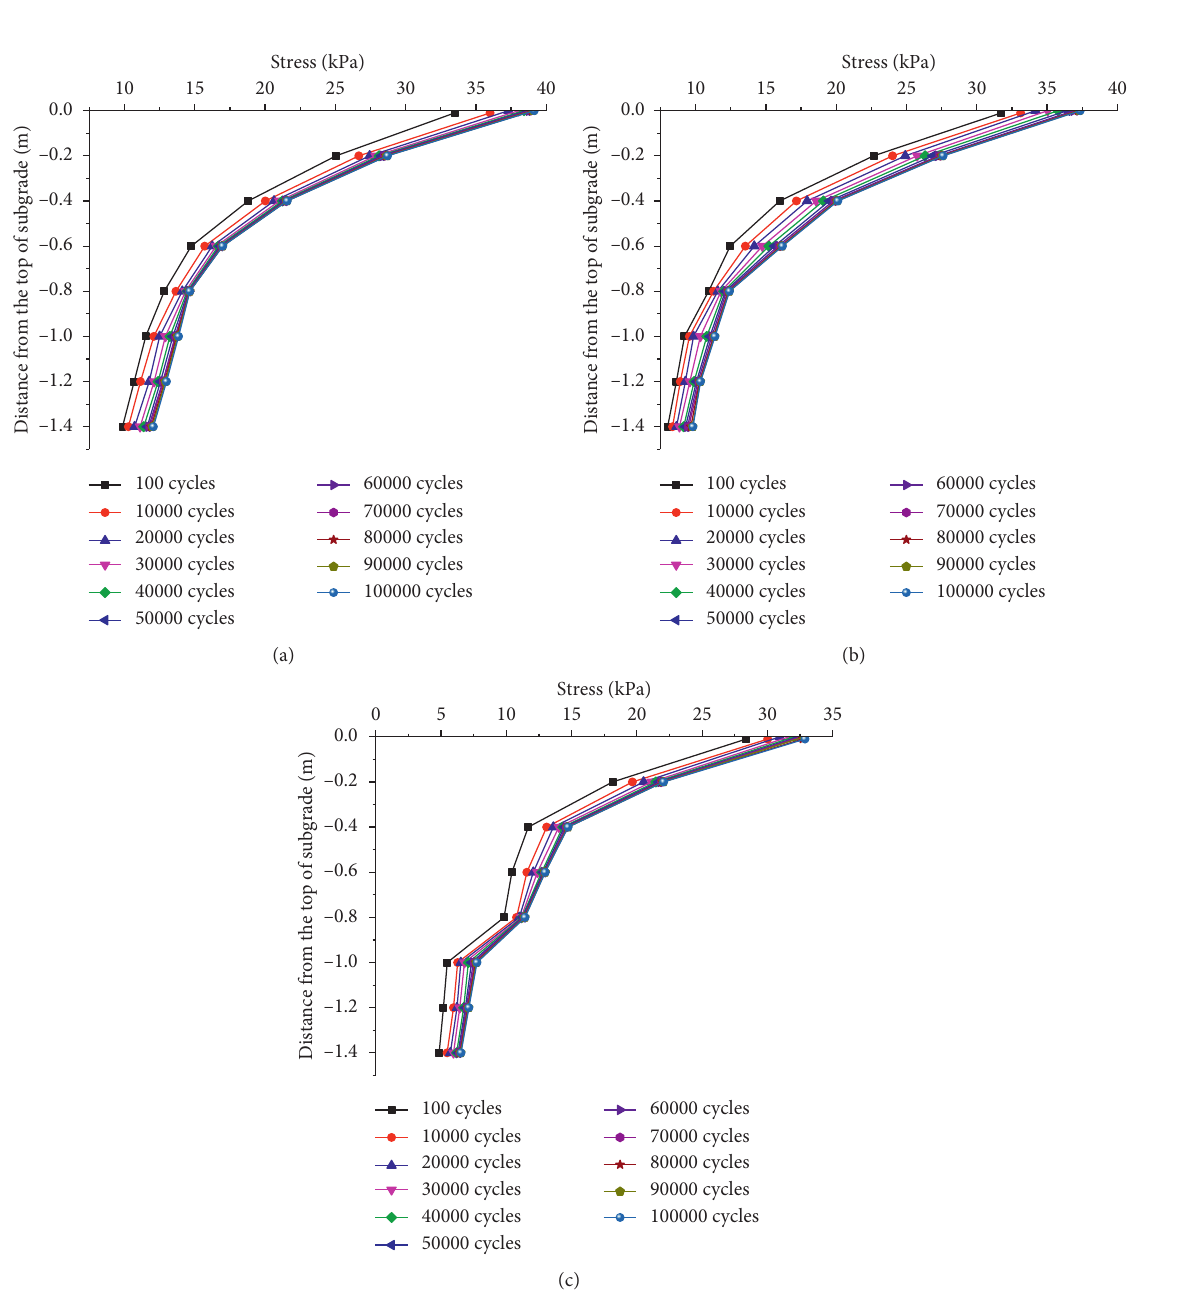
Figure 3: The relationships between stress and depth under different loading cycles. (a) The moisture content of the foundation was 18%. (b) The moisture content of the foundation was 23%. (c) The moisture content of the foundation was 28%.